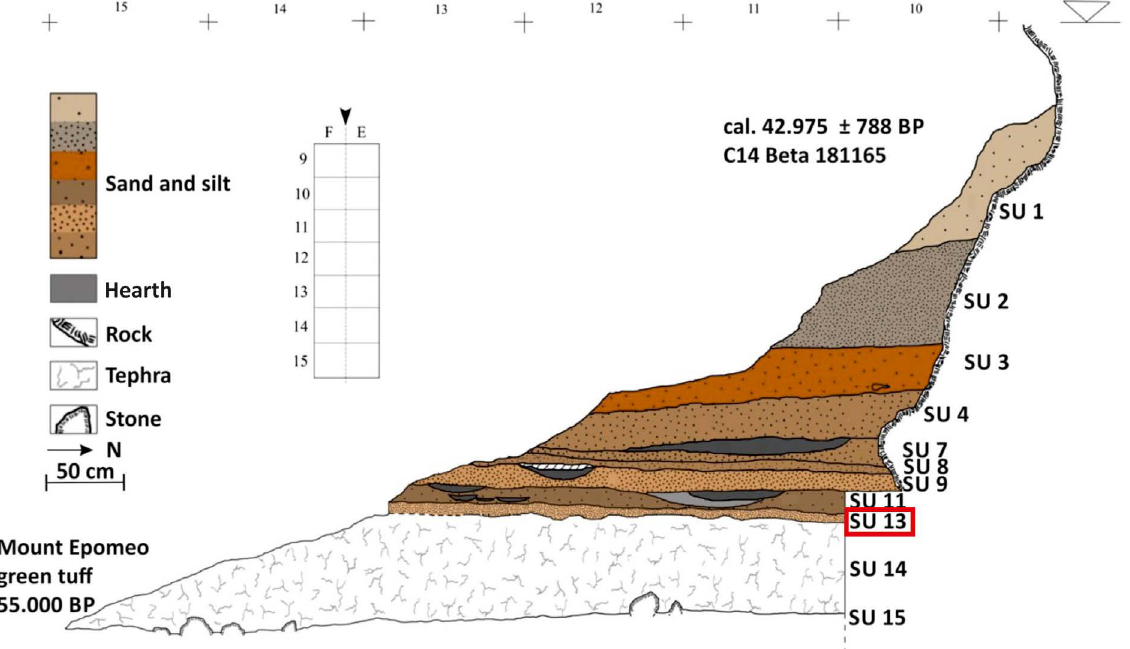
Figure 3. Stratigraphic sequence of the upper portion of Oscurusciuto rock shelter (sequence so far excavated) (Relief made by P. Boscato; drawing by A.